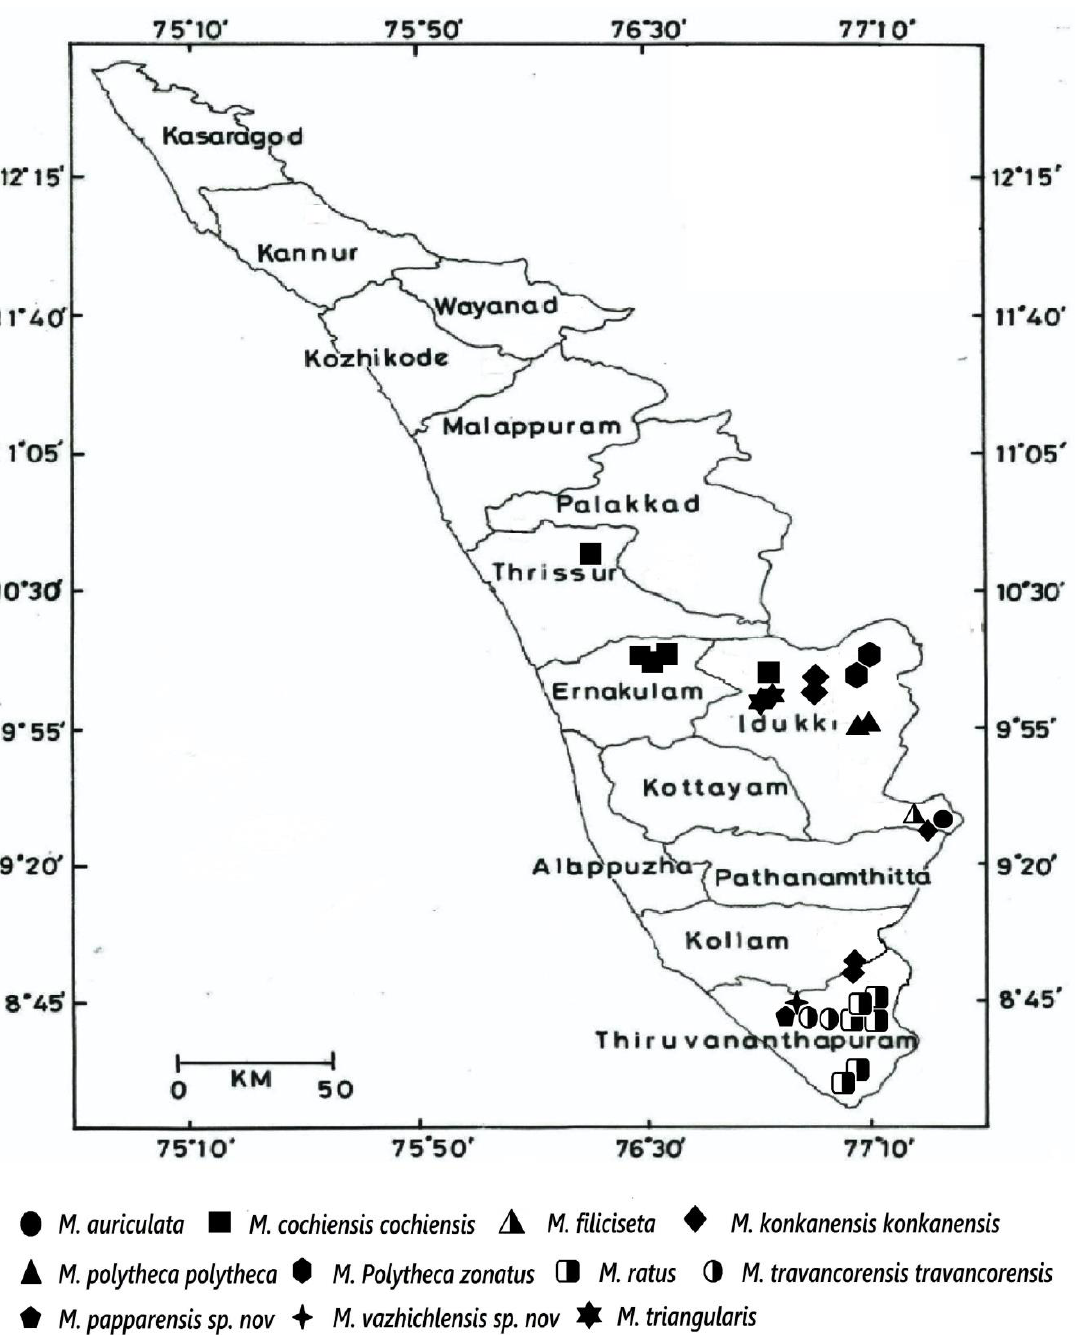
Figure 1. Collection of Megascolex species from various geographical spots of Kerala, Western Ghats, India.